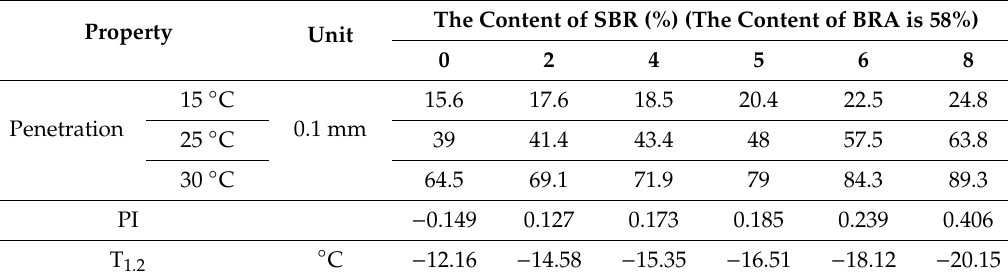
Table 10. Penetration of BRA-SBR composite modified